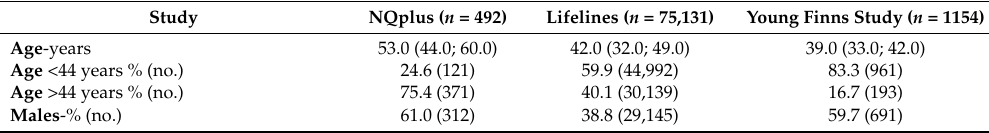
Table 1. Characteristics of the study populations ( n